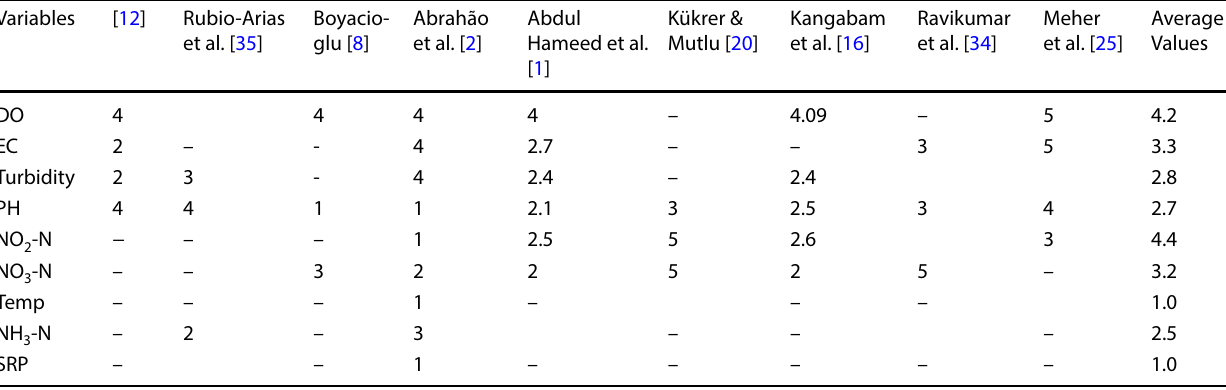
Table 2 Review of assigned weight for the physicochemical parameters